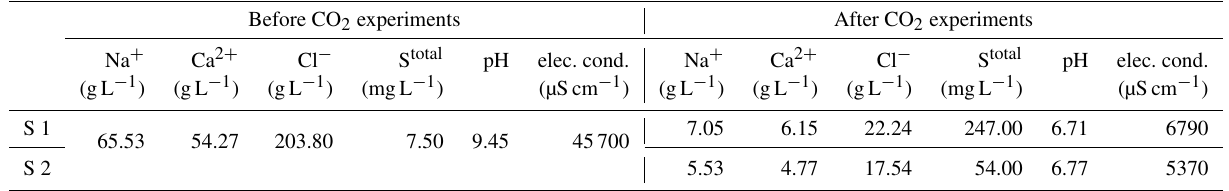
Table 3. Results of formation fluid analyses (ICP-MS/OES) of selected ions and the corresponding physicochemical data of two Permian autoclave runs, before and after CO 2 experiments under static reservoir conditions. Because of the common stratigraphic origin the initial formation brine composition is similar for both samples.